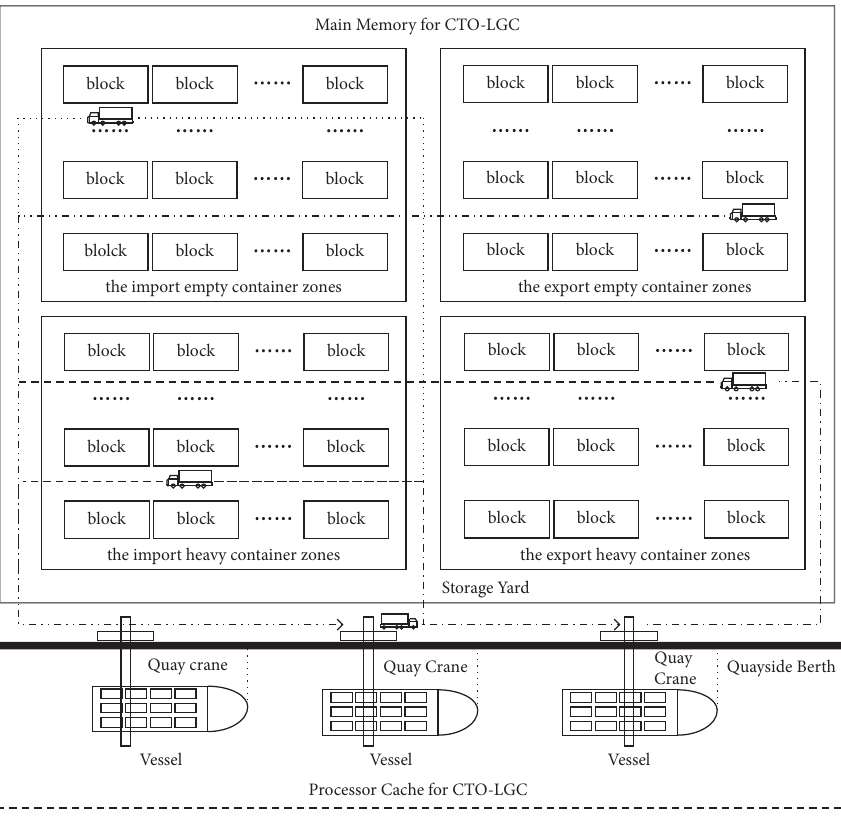
Figure 1: Abstract collaborative storage architecture for CTHS by computational